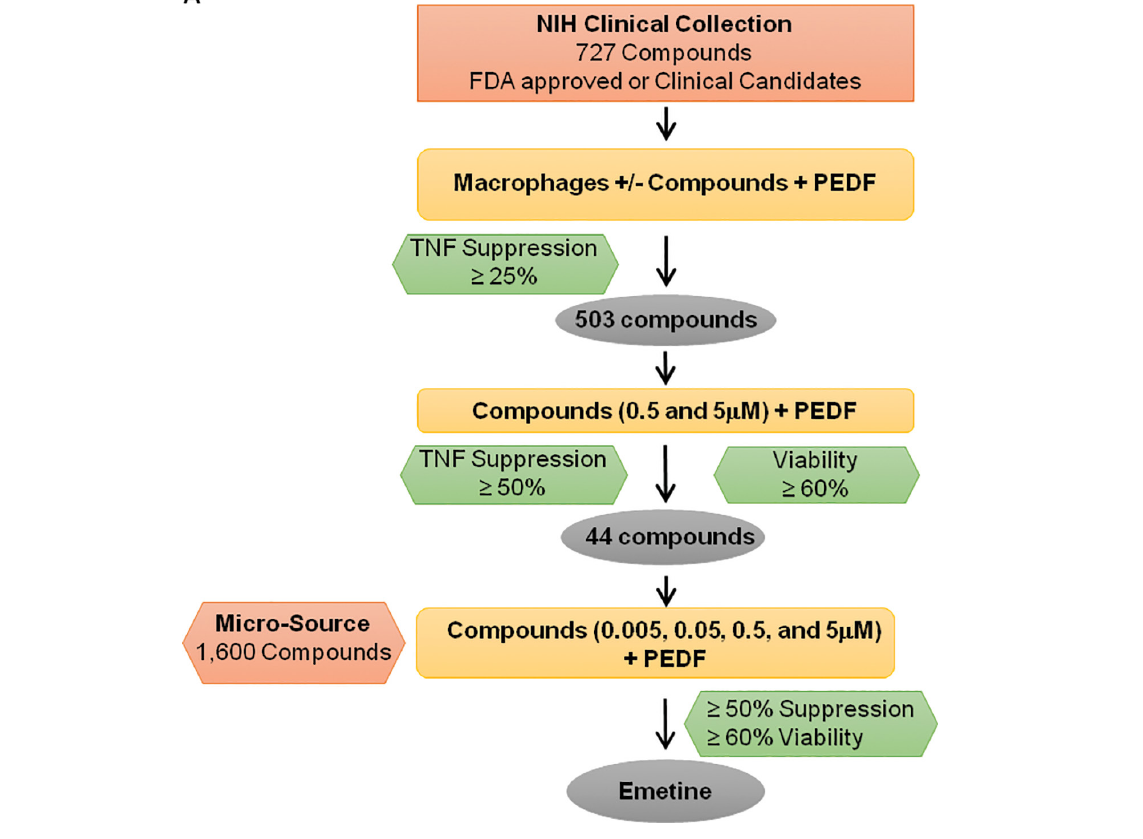
Figure 2. High-throughput screening for antagonists of PEDF-mediated macrophage activation. (A) Raw 264.7 cells were pre-exposed